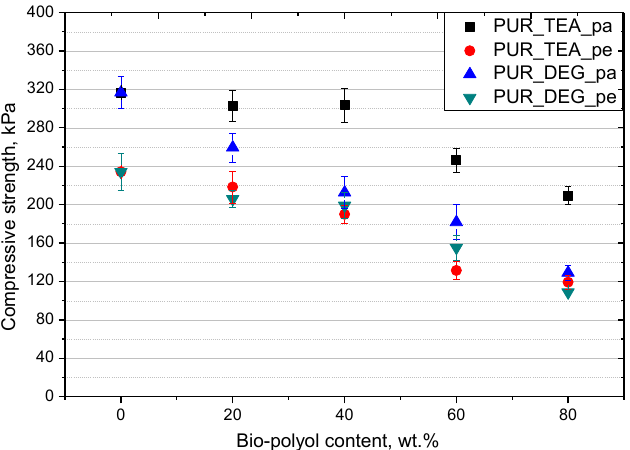
Figure 7. Compressive strength parallel (pa) and perpendicular (pe) to direction of foam rise of rigid PUR materials containing UCO_TEA and UCO_DEG bio-polyols.